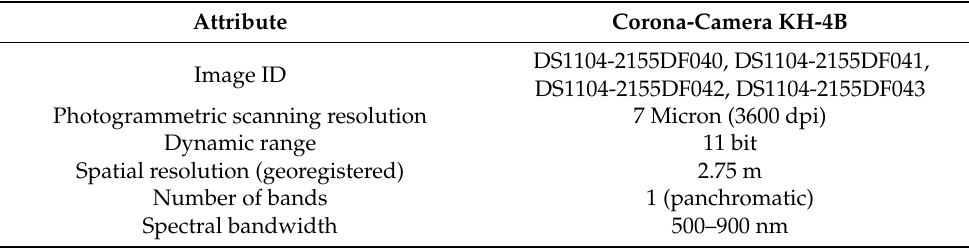
Figure 2. Tile of a Corona product as delivered by the United States Geological Survey (USGS) in 4 complementary parts. A scanner is used to scan the archived monochromatic camera film which contains the Corona image. Table 1. Technical specification of the Corona imagery used in the current